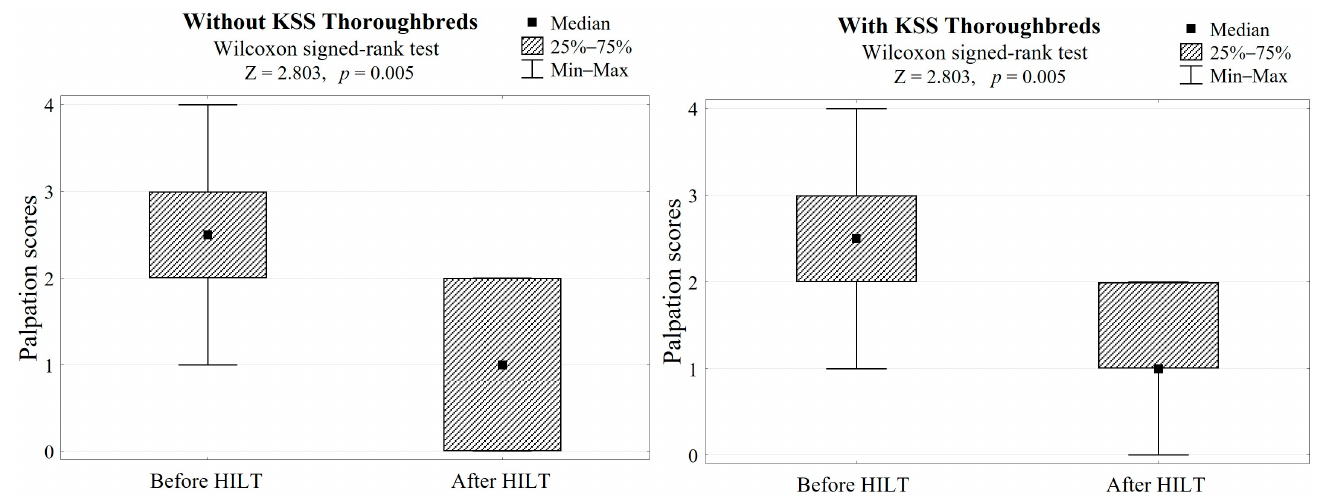
Figure 3. Differences in palpation scores after HILT application in both groups (with/without KSS) and the Wilcoxon signed-rank test results. Table 2. Correlation between changes in average skin surface temperatures ( ∆ T avg ) and changes in palpation scores ( ∆ PS ) after application of high-intensity laser therapy (HILT) in groups with Kissing Spines Syndrome (KSS) and without KSS and results of Spearman’s rank correlation coefficient (rho).